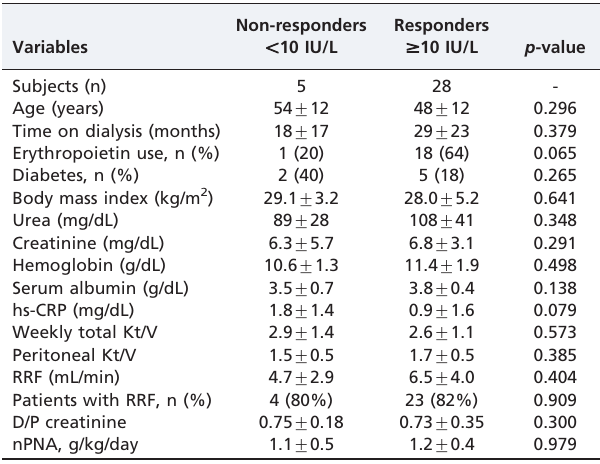
Table 2 - Responses to four-dose HBV vaccination schedule measured by anti-HBs titers and clinical, laboratory, dialysis adequacy, and residual renal function results in 33 peritoneal dialysis patients. Values are expressed as the mean ¡ SD, unless otherwise noted.